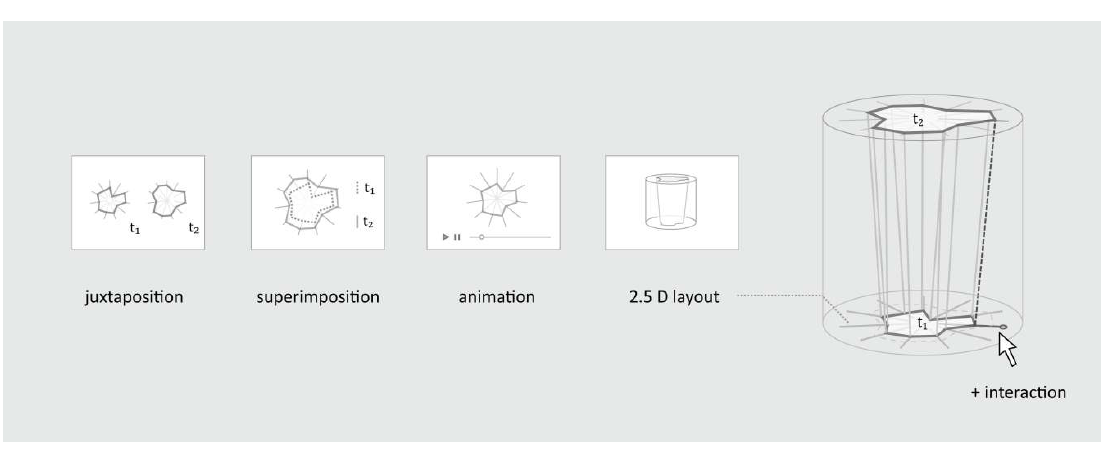
Figure 6: Different methods of visualizing change over time (from t superimposition, animation, and 2.5D layout, with the close up illustrating the supporting role of interaction